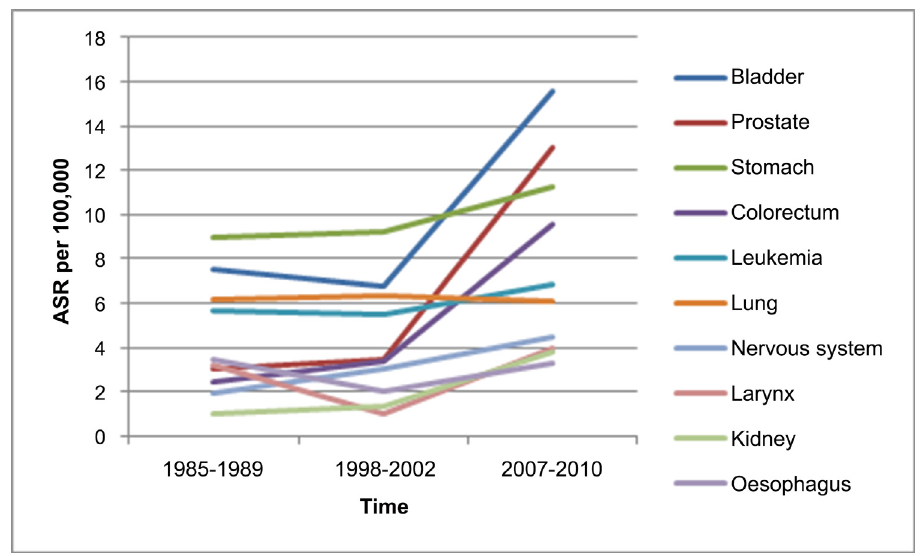
Fig 3. Changing the incidence of top ten cancers in men based on age-standardized rates per 100,000 person-years (ASR) in Fars province, Iran during three time periods. This figure shows changes in the incidence of top ten cancers in men based on age-standardized rates per 100,000 person-years (ASR) in Fars province, Iran during 1985 – 1989, 1998 – 2002, and 2007 – 2010 time period.